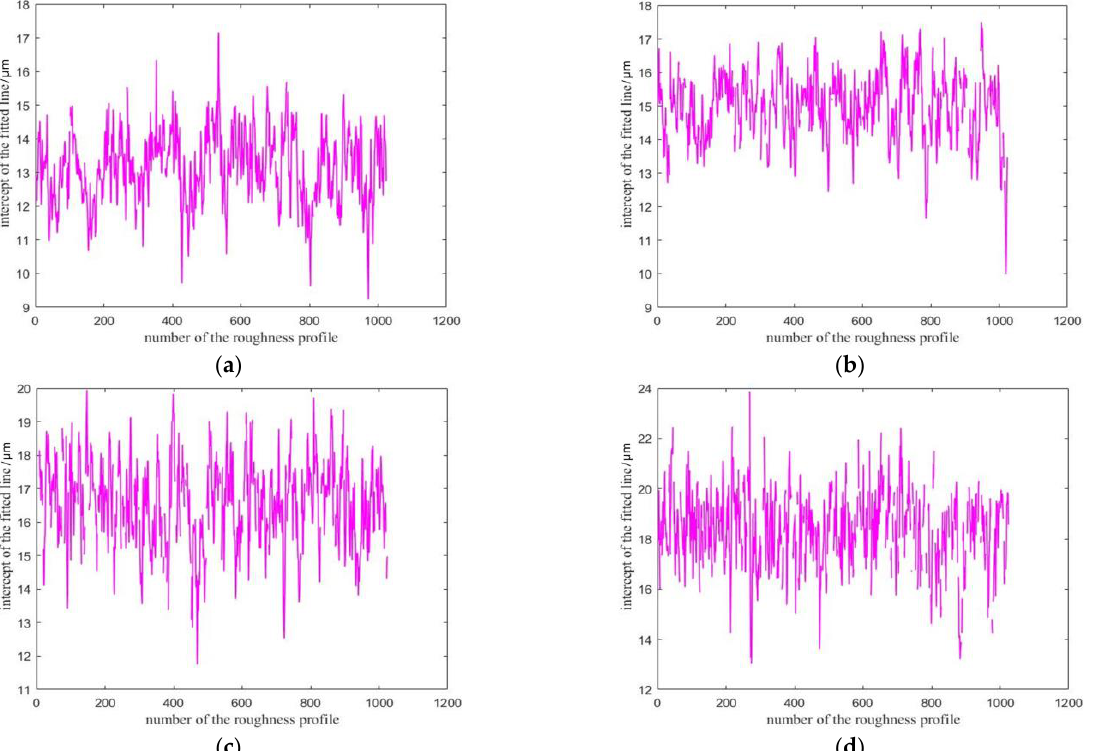
Figure 7. Results of 1024 intercepts under each scale (WC-Ni). ( a ) 100 × ; ( b ) 50 × ; ( c ) 25 × ; ( d ) 10 ×